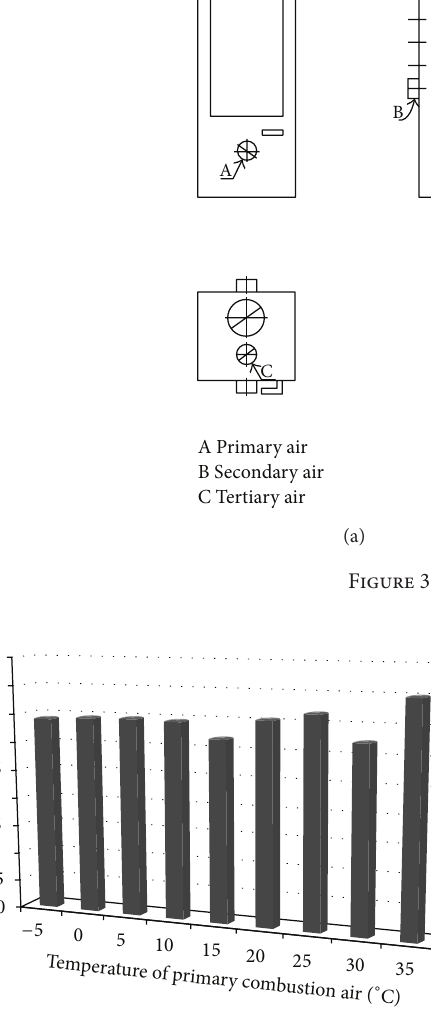
Figure 4: Average CO 2 emissions depending on the temperature change of the primary combustion air.